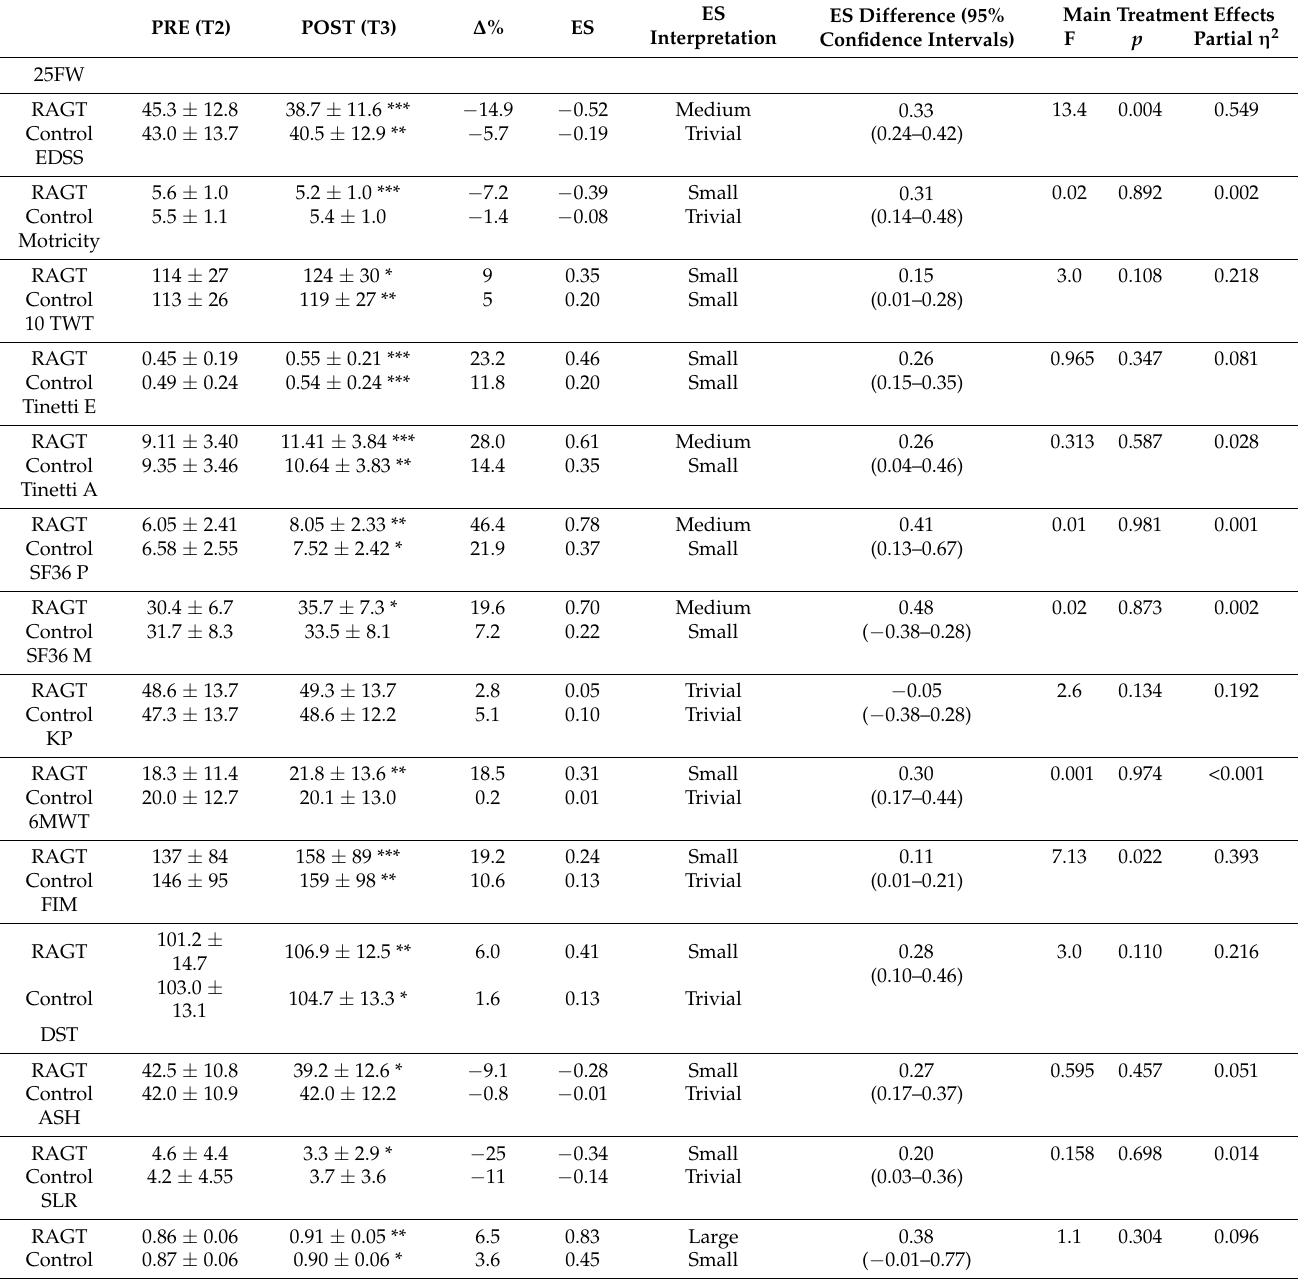
Table 2. Outcome changes according to the training